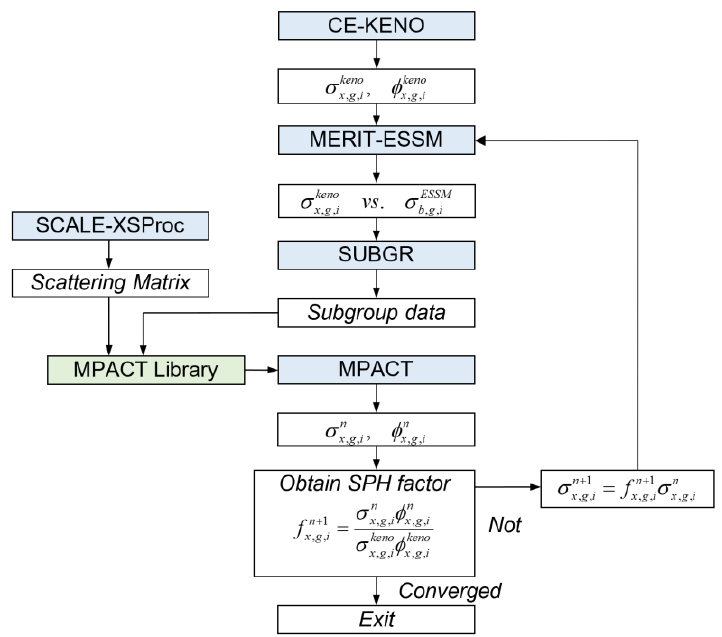
Figure 5. Procedure to generate the SPH